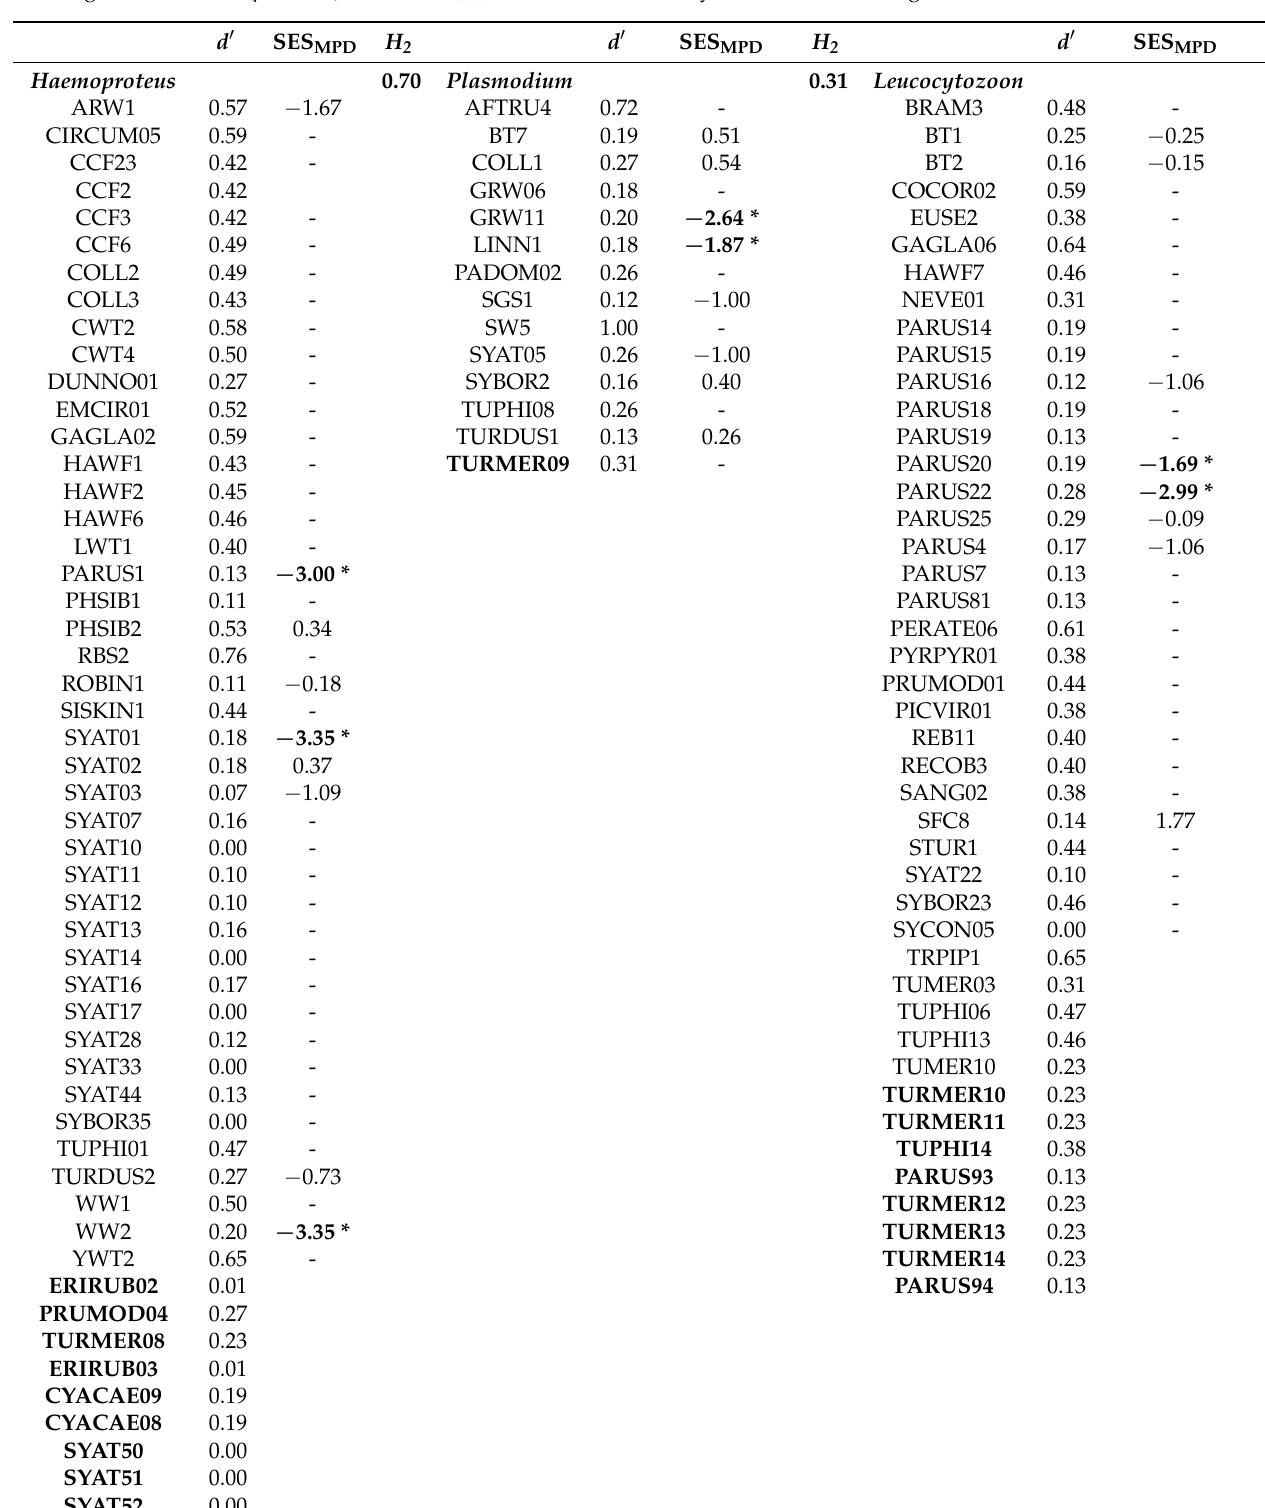
Table 7. List of haemosporidian cytochrome b lineages detected in Drienovec, Slovakia, during 2017, 2018 and 2019. For each lineage, we report values of structural host specificity in terms of the d (cid:48) and H 2 indices, phylogenetic specificity in terms of the SES MPD index. The indices were calculated at the level of haemosporidian lineage ( d (cid:48) , SES MPD ) or genus ( H 2 ). Significant values ( p ≤ 0.05) for the SES MPD index are denoted by asterisk. New lineages are in